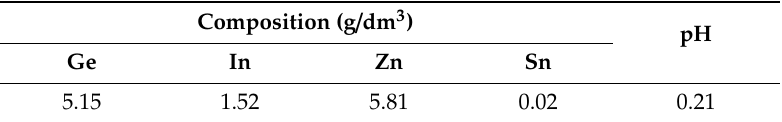
Table 2. Composition of detinned solution used in cementation